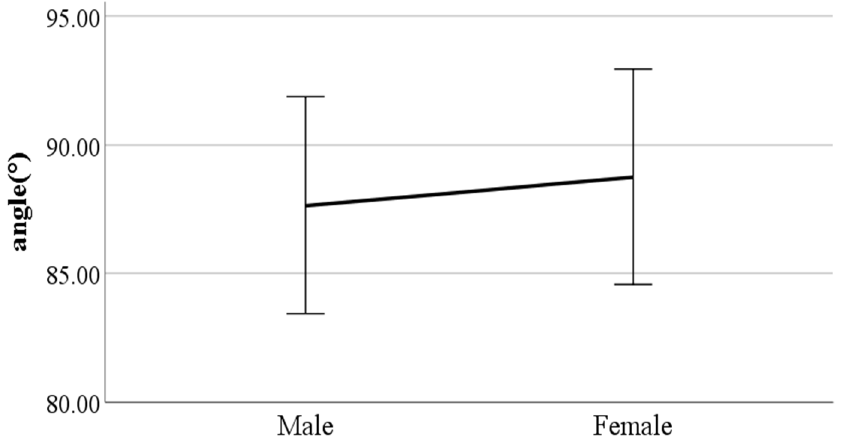
Figure 18. Gender difference in mean forward/backward trunk bending (F value: 0.22, DF: 289, p -value: 0.03).